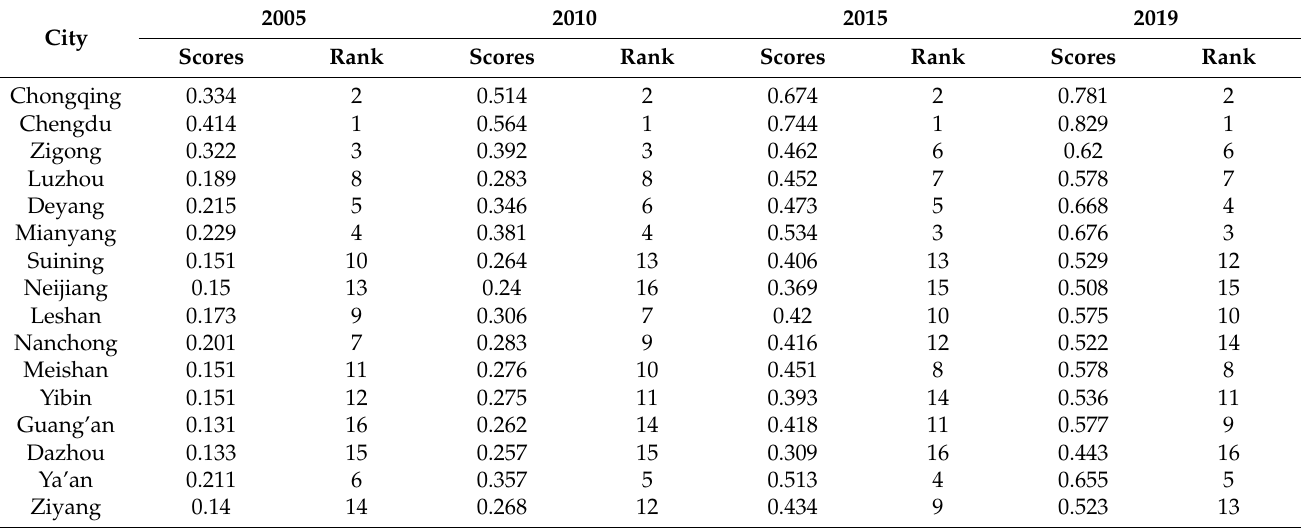
Table 4. Urban Resilience Scores in the Chengdu–Chongqing Urban